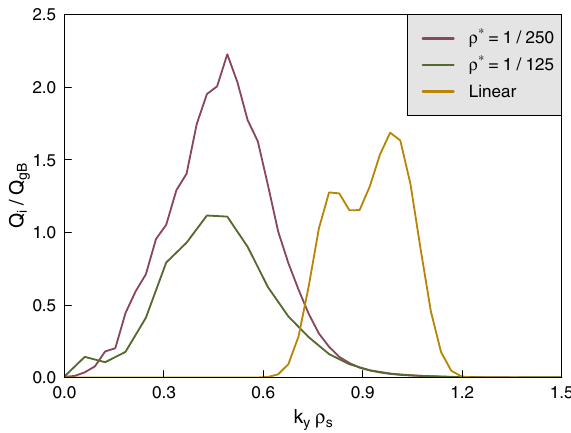
FIG. 8. Heat flux spectra for QUASAR in the two ρ (cid:3) regimes ð 1 =L ¼ 3 Þ compared to a linear fluctuation spectrum (rescaled; T i ρ (cid:3) ¼ 1 = 250 ), showing the difference between dominant scales.